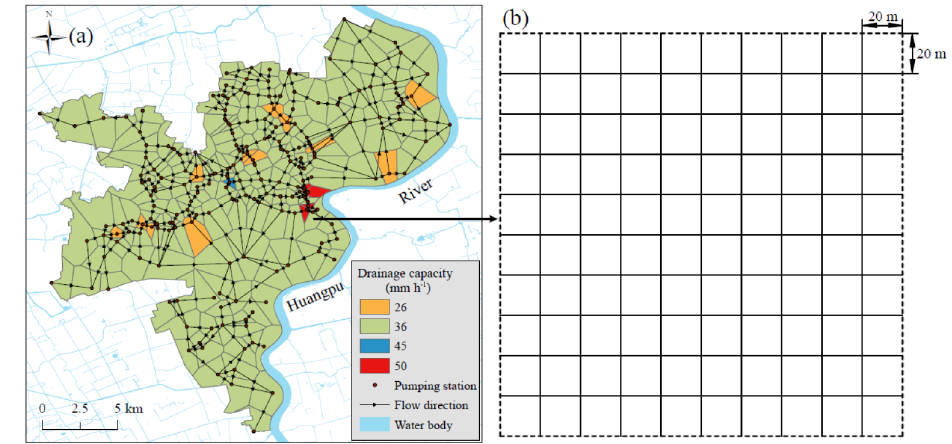
Figure 2. Calculated subcatchments and grids in the SWMM and GIS: (a) drainage capacity and flow direction of each subcatchment; (b) calculated grid of each